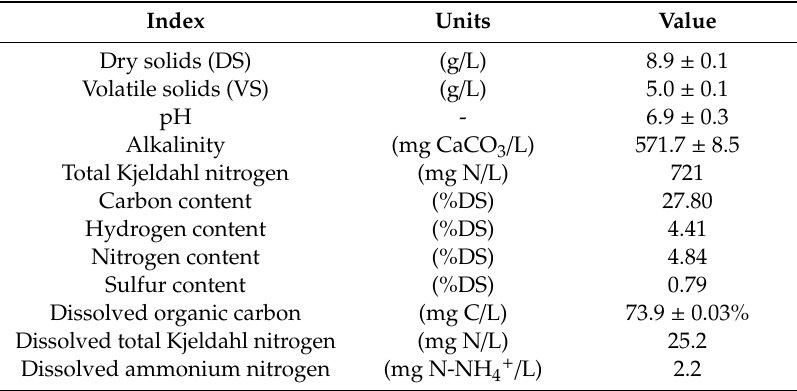
Table 1. Characteristics of collected sludge from water